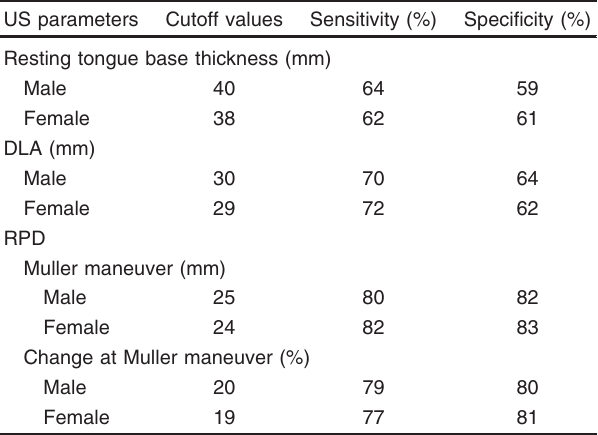
Table 9 Accuracy, sensitivity, and specificity of the possible optimal cutoff values of the individual anatomical and dynamic ultrasonography indices for diagnosis of obstructive sleep apnea US parameters